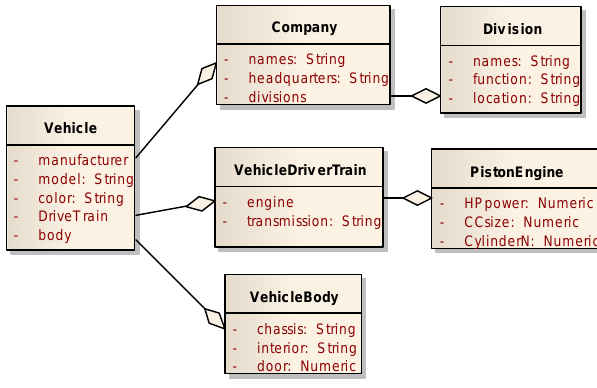
Figure 1 . An example of a nested object